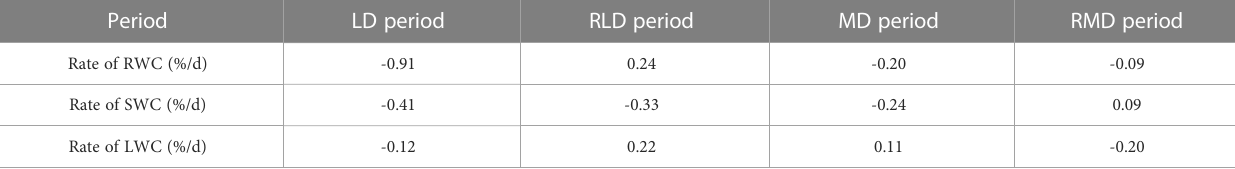
TABLE 2 Analysis on the rate of increase (decrease) of the water content of component organs under different